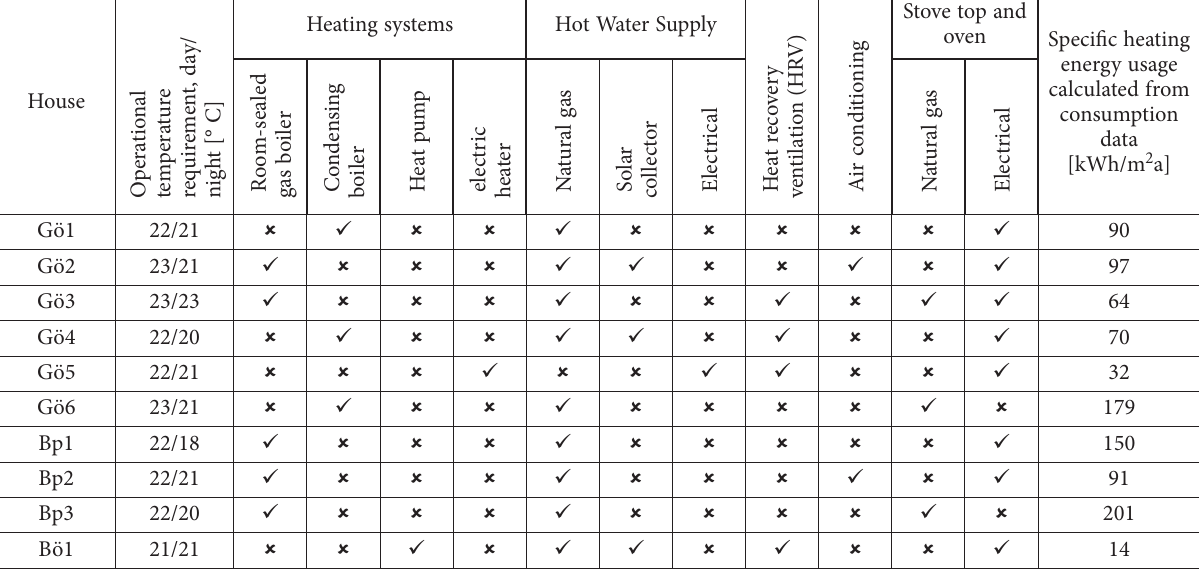
Table 2. Operational parameters of sampled